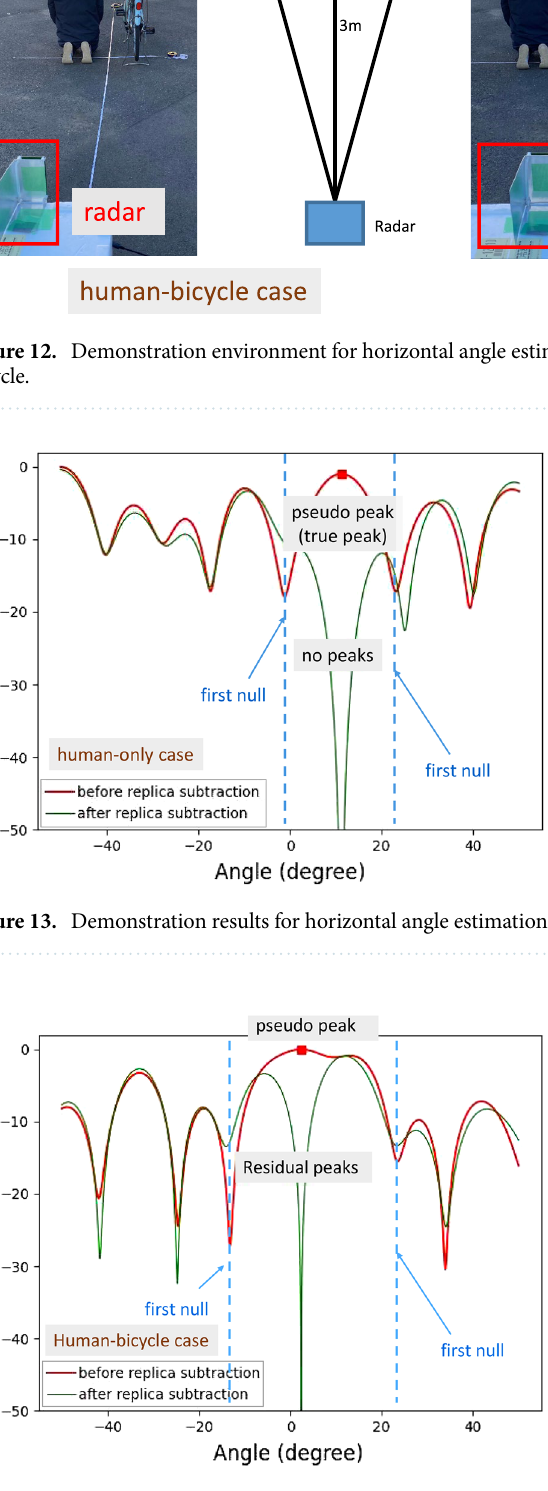
Figure 14. Demonstration results for horizontal angle estimations of on-road obstacles: